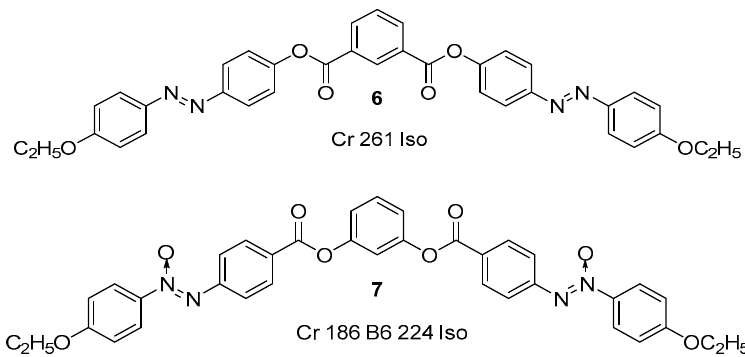
Figure 2. Chemical structure of historical bent-core molecules 6 and 7 synthesized by Vorländer [73].